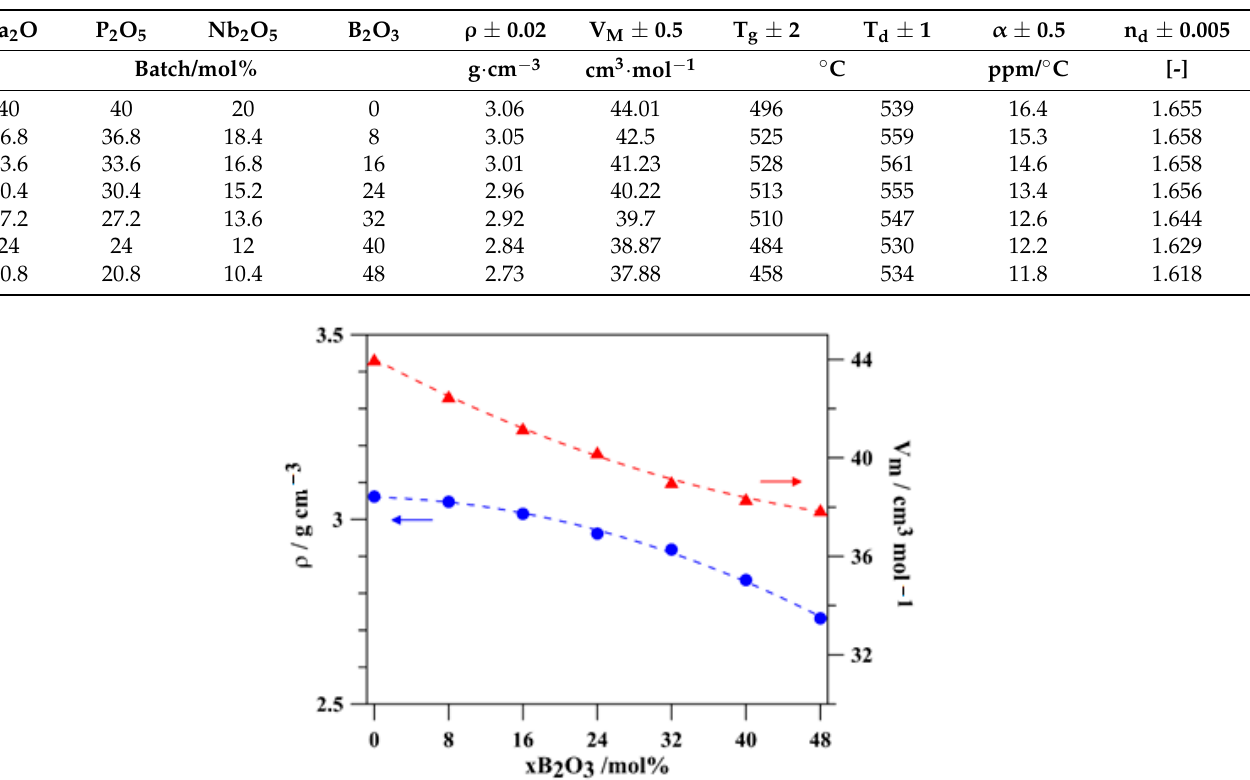
Table 1. Composition, density, ρ , molar volume, V M , glass transition temperature, T g , dilatometric softening temperature, T d , the coefficient of thermal expansion, α , and the index of refraction, n d , of